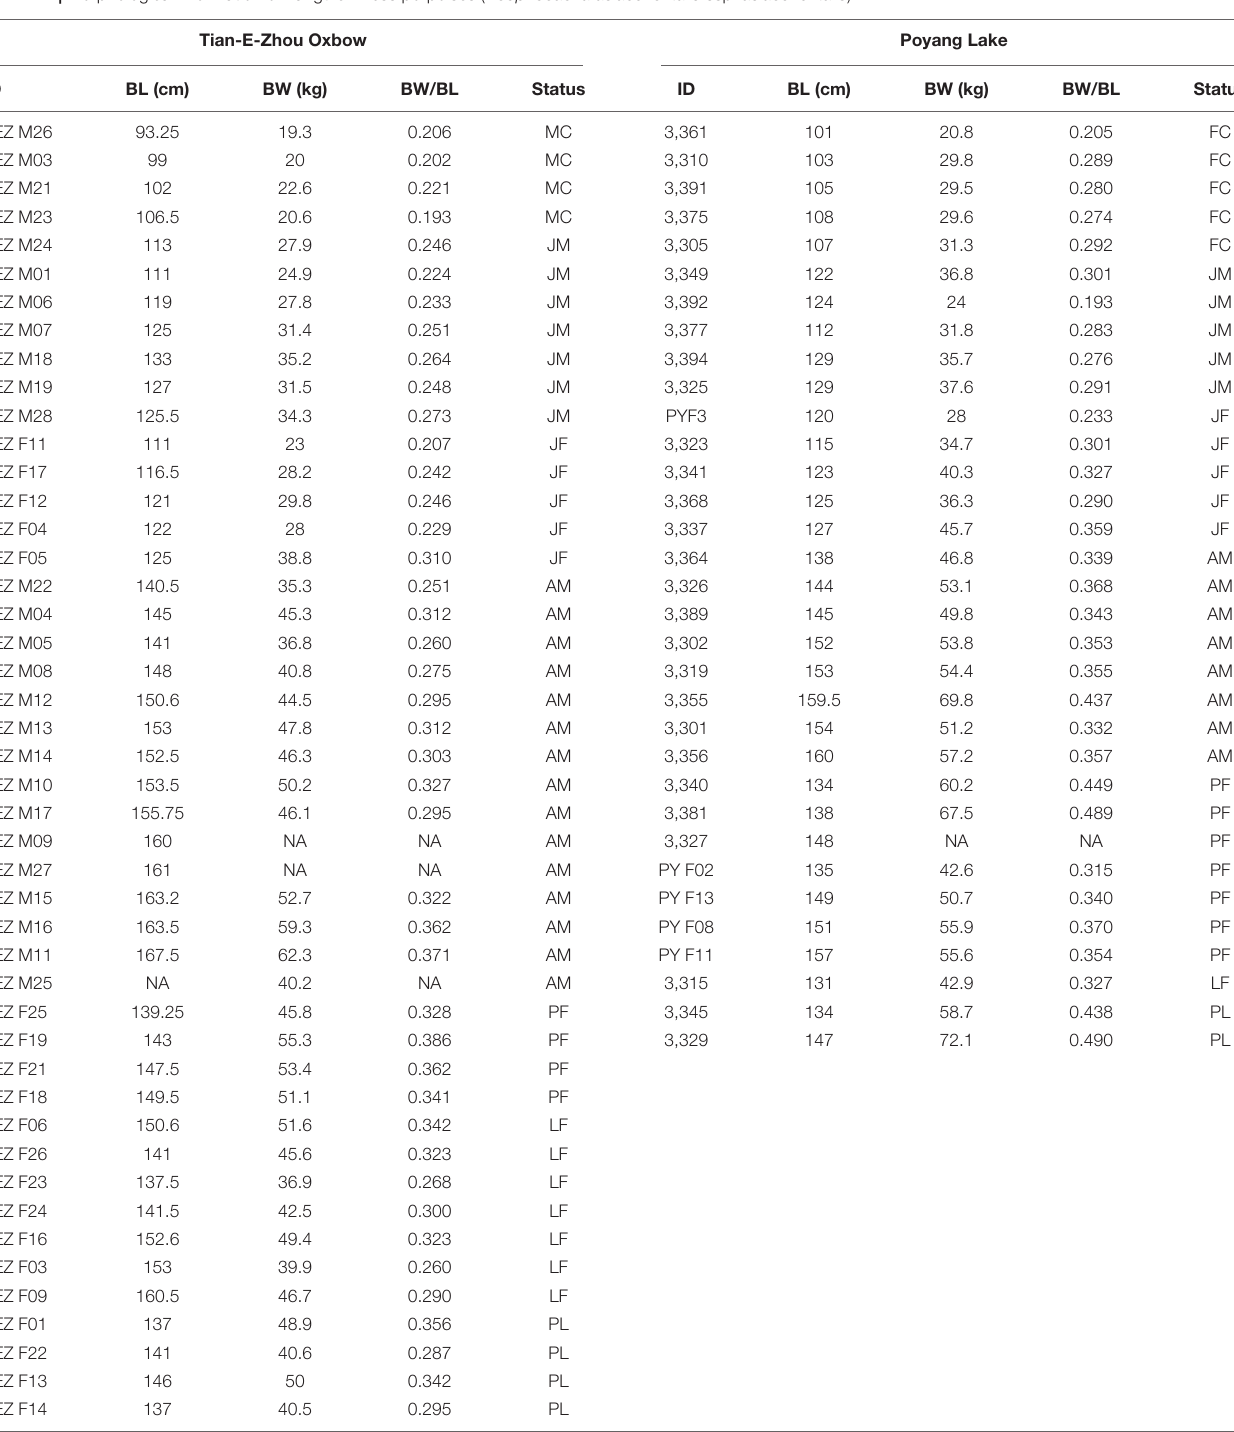
TABLE 1 | Morphological information of Yangtze finless porpoises ( Neophocaena asiaeorientalis ssp. asiaeorientalis ). Tian-E-Zhou Oxbow